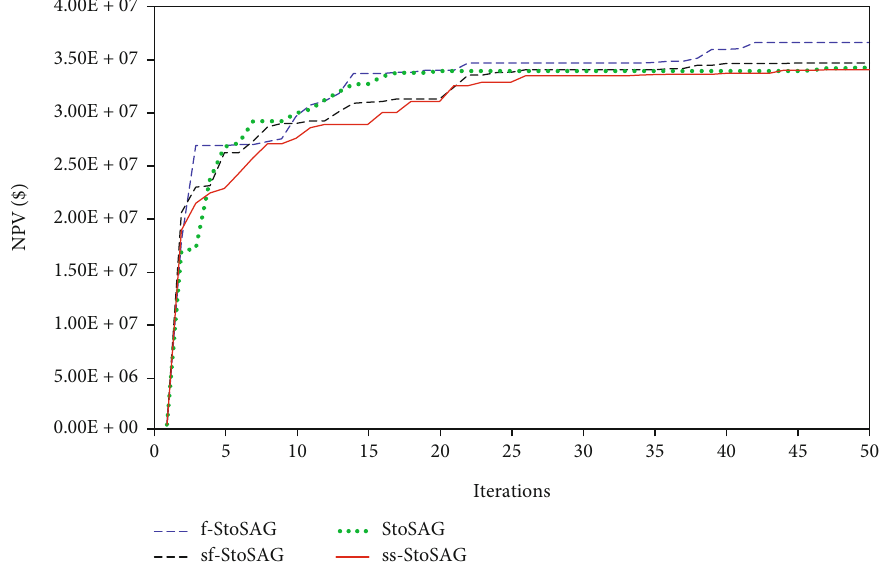
Figure 19: The NPV with respect to number of iterations based on di ff erent